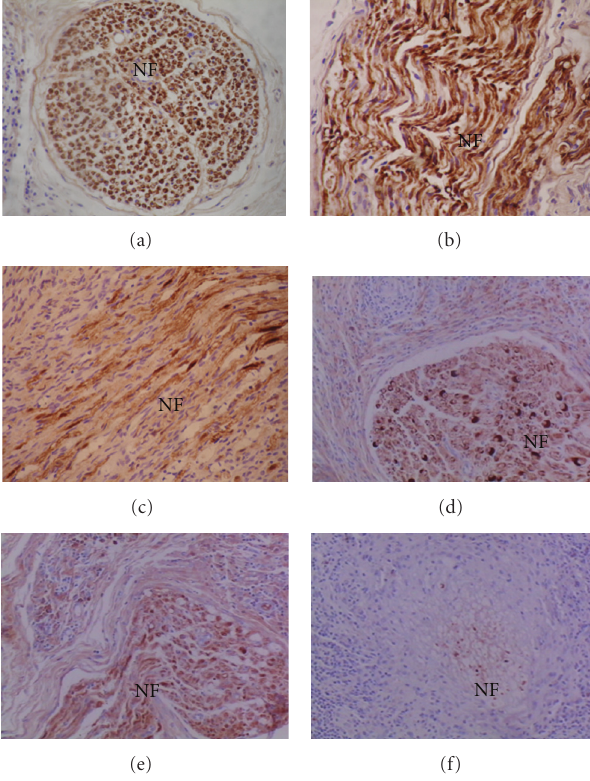
Figure 2: Rapid and progressive loss of axons in mouse nerve xenografts. Autologous (a)–(c) and xenogeneic mouse (d)–(f) nerve grafts were harvested at weeks 2 (a) and (d), 4 (b) and (e), and 8 (c) and (f) posttransplantation and analyzed by immunohisto- chemistry with S-100 staining. Five rats per group were examined at each time point (these are the same animals shown in Figure 1), and representative samples ( x 40) are shown. NF, nerve